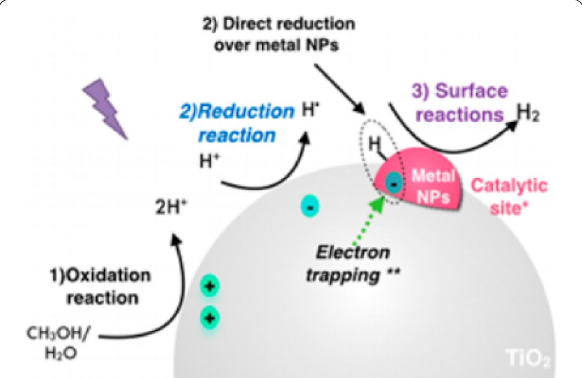
Fig. 3 Schematic illustration of the photocatalytic H 2 evolution using Pt/TiO 2 in the presence of CH 3 OH and H 2 O. Reprinted with permission from Luna et al. [28] (Copyright 2017 American Chemical